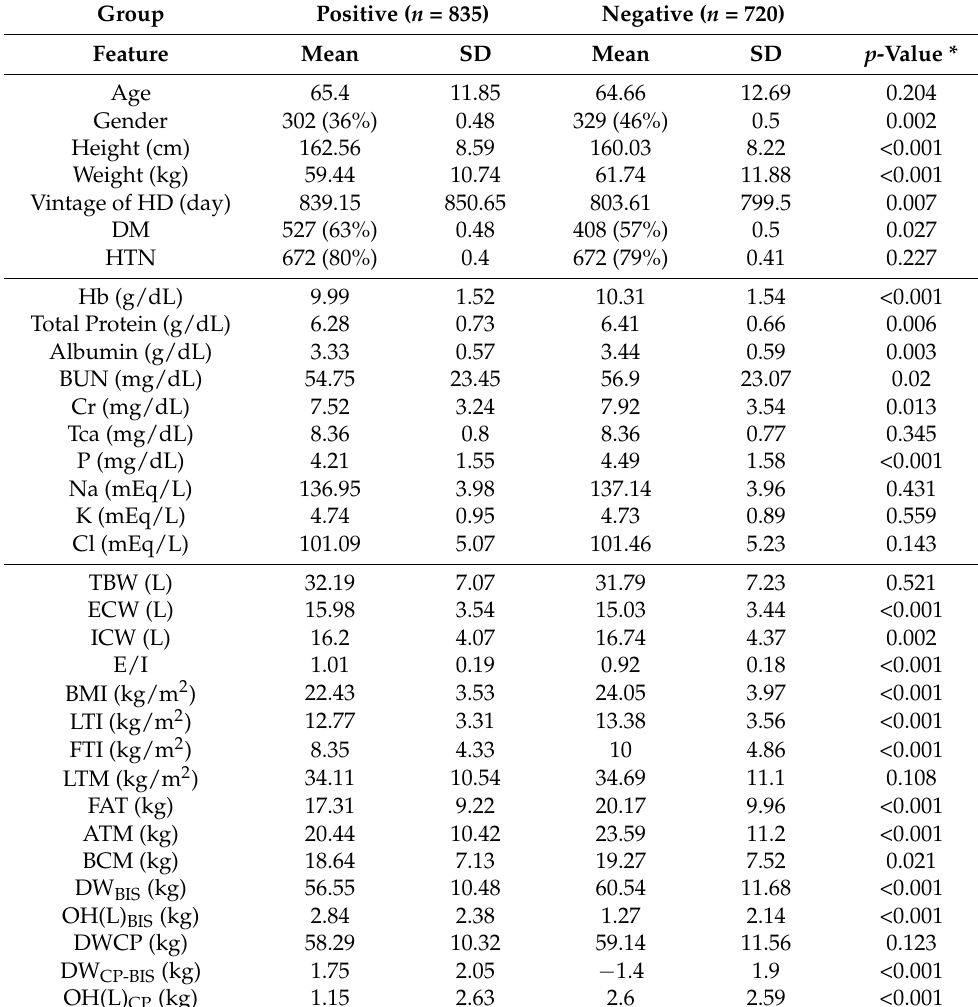
Table 1. Baseline characteristics between positive and negative of DW CP-BIS